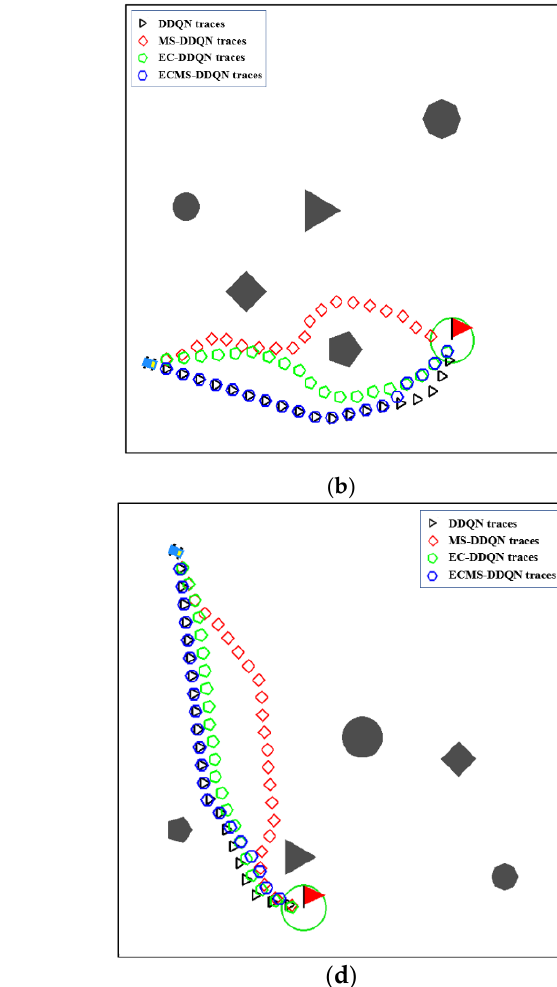
Figure 9. Planning path of four algorithms in four random scenes. ( a ) Path planning results of the first random environment. ( b ) Path planning results of the second random environment. ( c ) Path planning results of the third random environment. ( d ) Path planning results of the fourth random environment.